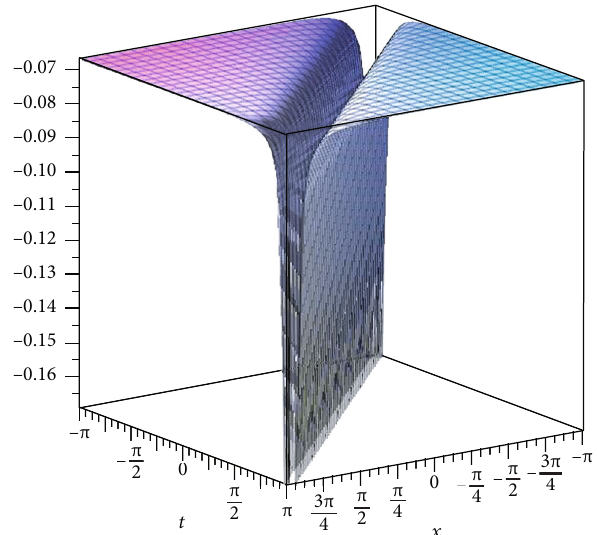
= 1, 1 Figure 5: Graphical behavior for ϕ